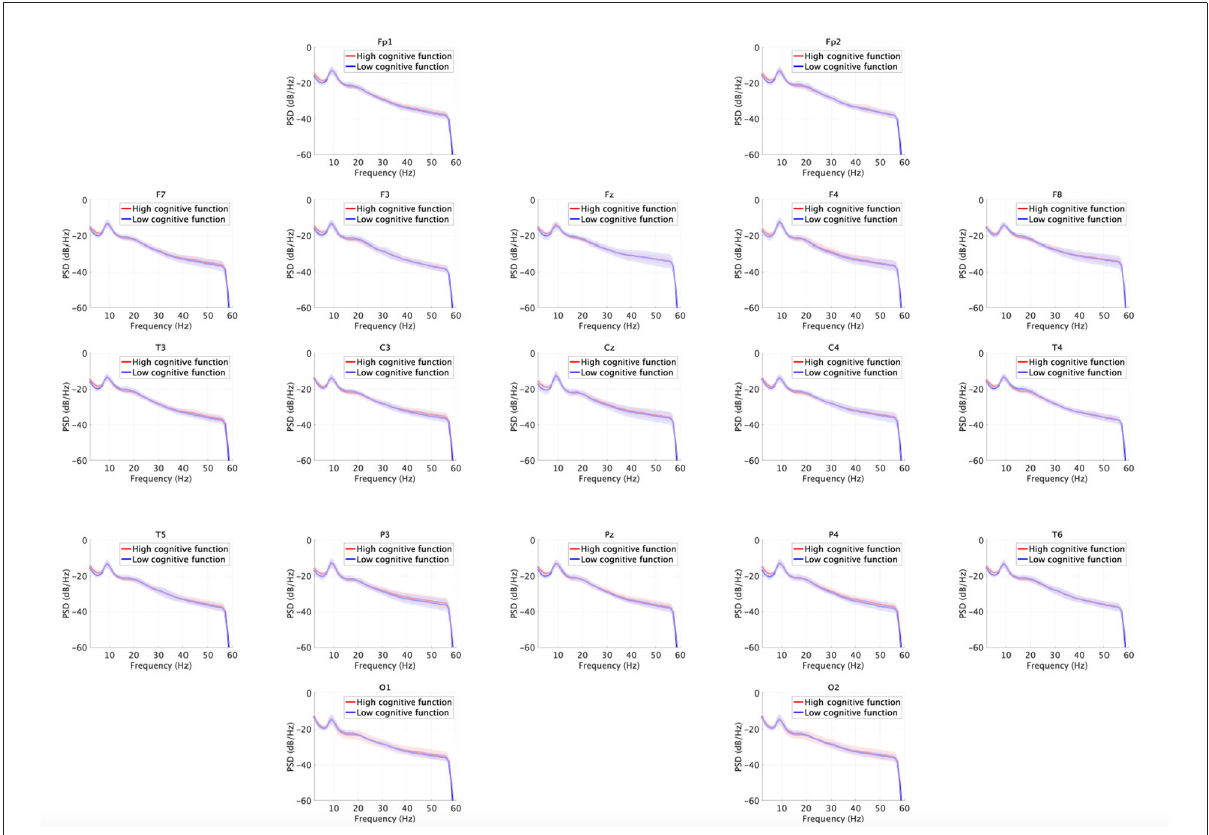
FIGURE3 EEG power spectral density (PSD) for the high and low cognitive function groups. Solid lines and shaded areas indicate mean and standard deviation in each group. We found no significant differences after adjusting for false discovery rate (FDR) with q < 0.05.